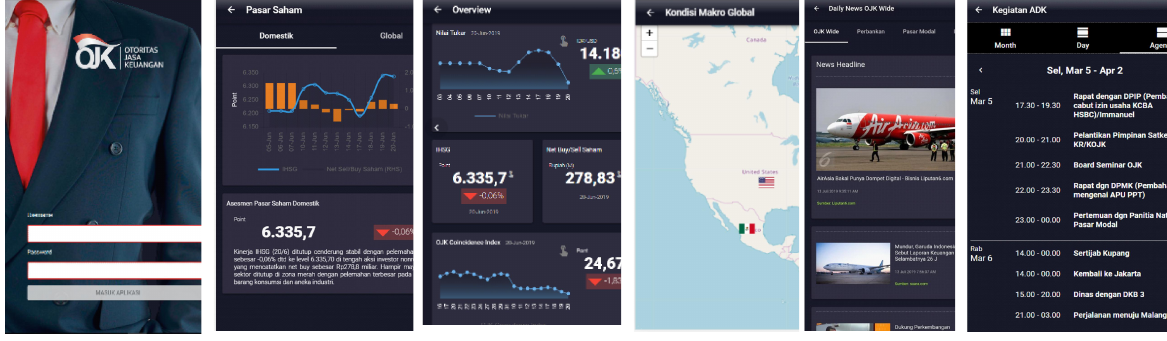
Fig. 5. Fragment of UI